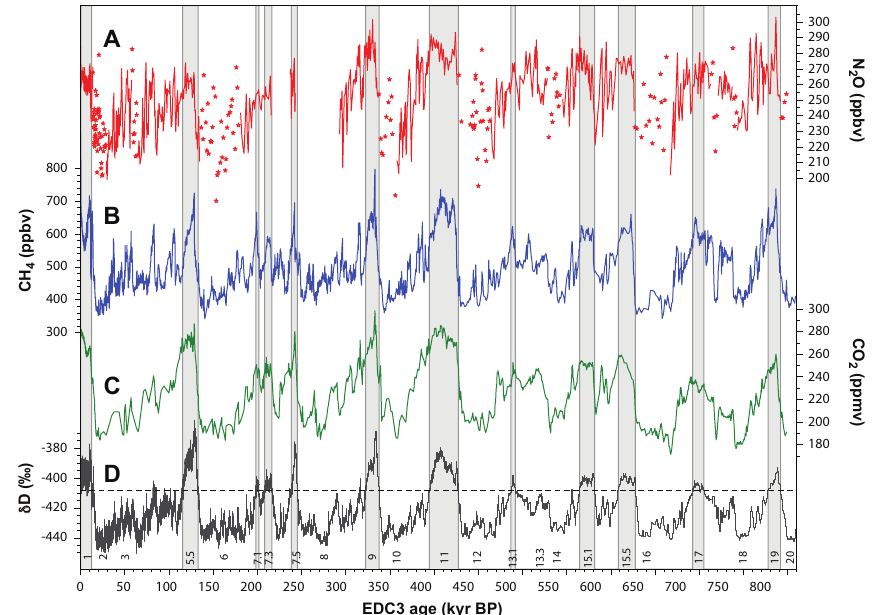
Fig. 9. Variations, over the last 800000yr, of deuterium ( δ D; black), a proxy for local temperature, and the atmospheric concentrations of the greenhouse gases CO 2 (green), CH 4 (blue), and nitrous oxide (N 2 O; red) derived from air trapped within ice cores from Antarctica (Schilt et al.,